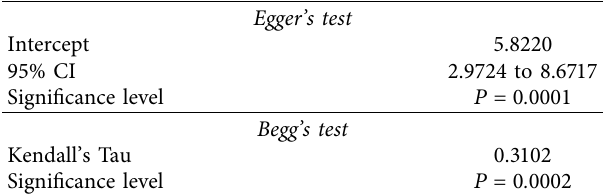
Table 4: Publication bias test for the study related to the prevalence of Brucella